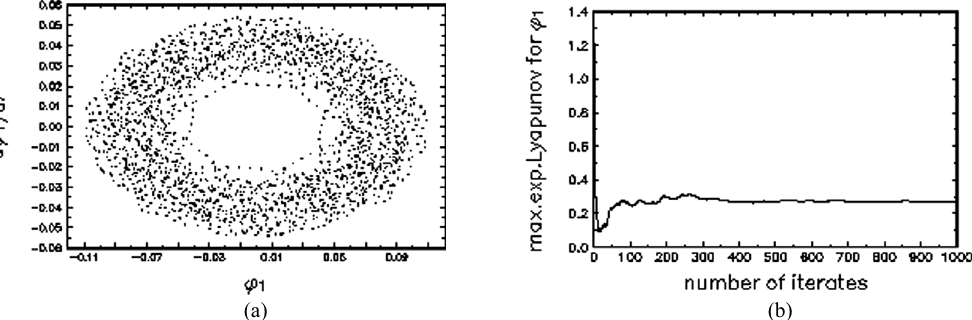
Fig. 11. Poincaré map (a) and Lyapunov exponents (b) of ϕ 1 for γ 4 = 0 and for: a 1 = a 2 = 0.1; a 3 = 0.0001; γ 1 = 0.0001; γ 2 = γ 3 = 0; β